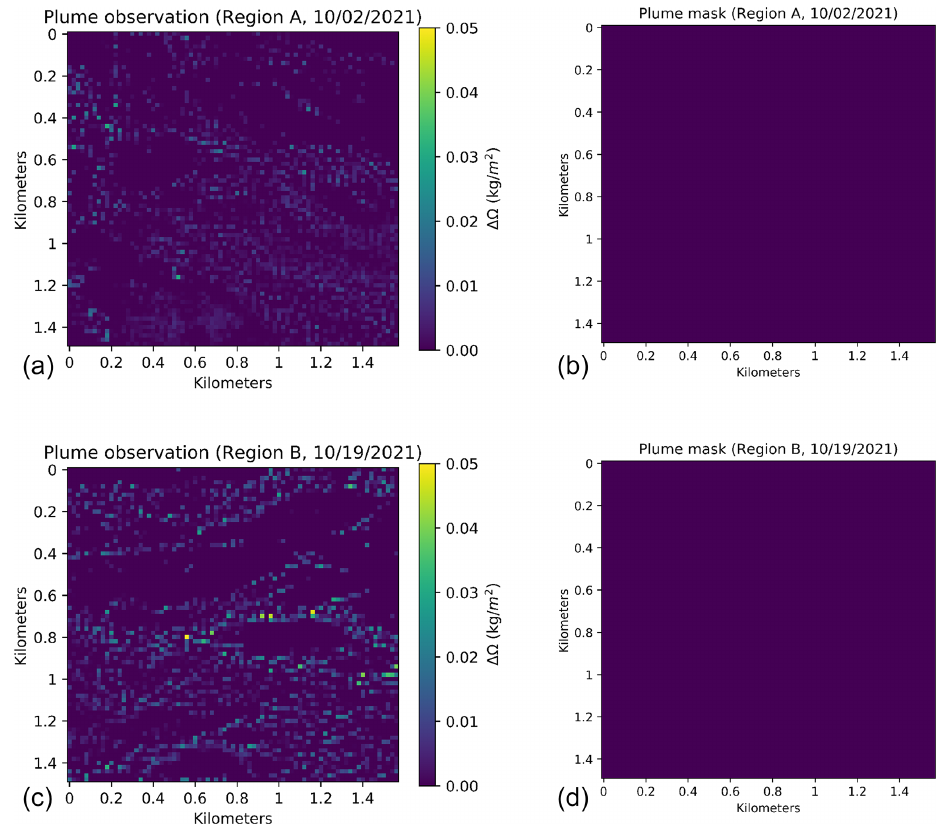
Figure 9. Two examples of application studies. Panels (a) and (b) show an application case on 2 October 2021 in region A, and (c) and (d) show a case on 19 October 2021 in region B. Both examples have true negative detection. All of the other dates in the application studies have true negative detection as